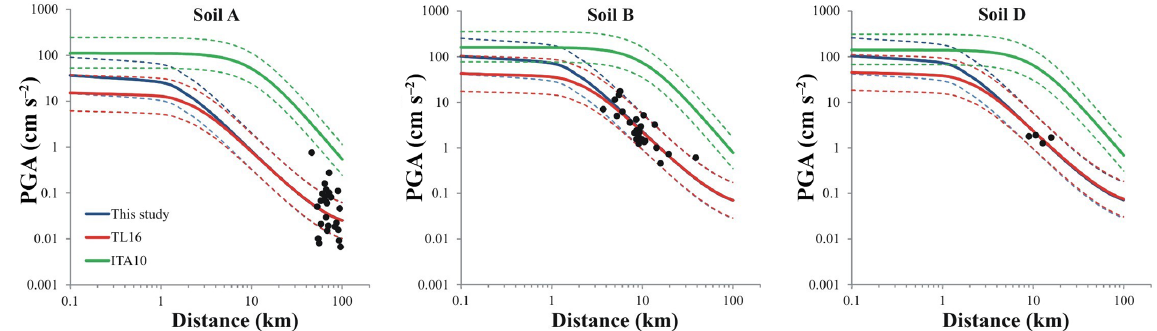
Figure 3. Predicted mean attenuation curves for a M L = 4 earthquake by the empirical law estimated in this study: ETNAhy, (continuous blue lines), TL16 (continuous red lines) and ITA10 (continuous green line). The dashed lines represent the standard deviation of the mean. The black circles refer to the observations of our dataset with 3.9 ≤ M L ≤ 4.1; the three frames represent different soil types according to the EC8 Building